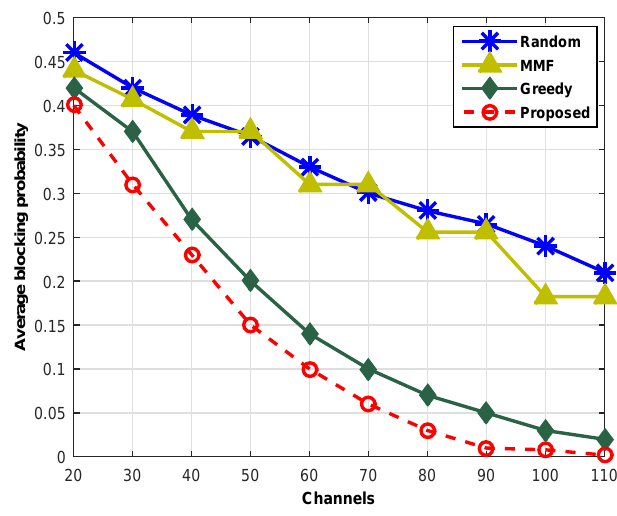
Figure 10. Blocking probability across different channels.